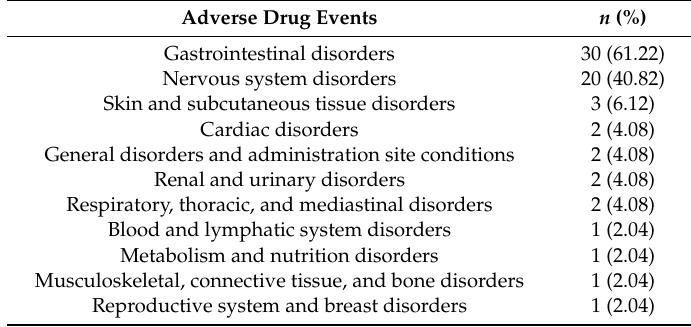
Table 1. Frequency of adverse drug events in severely obese adults, by organ and system classification.